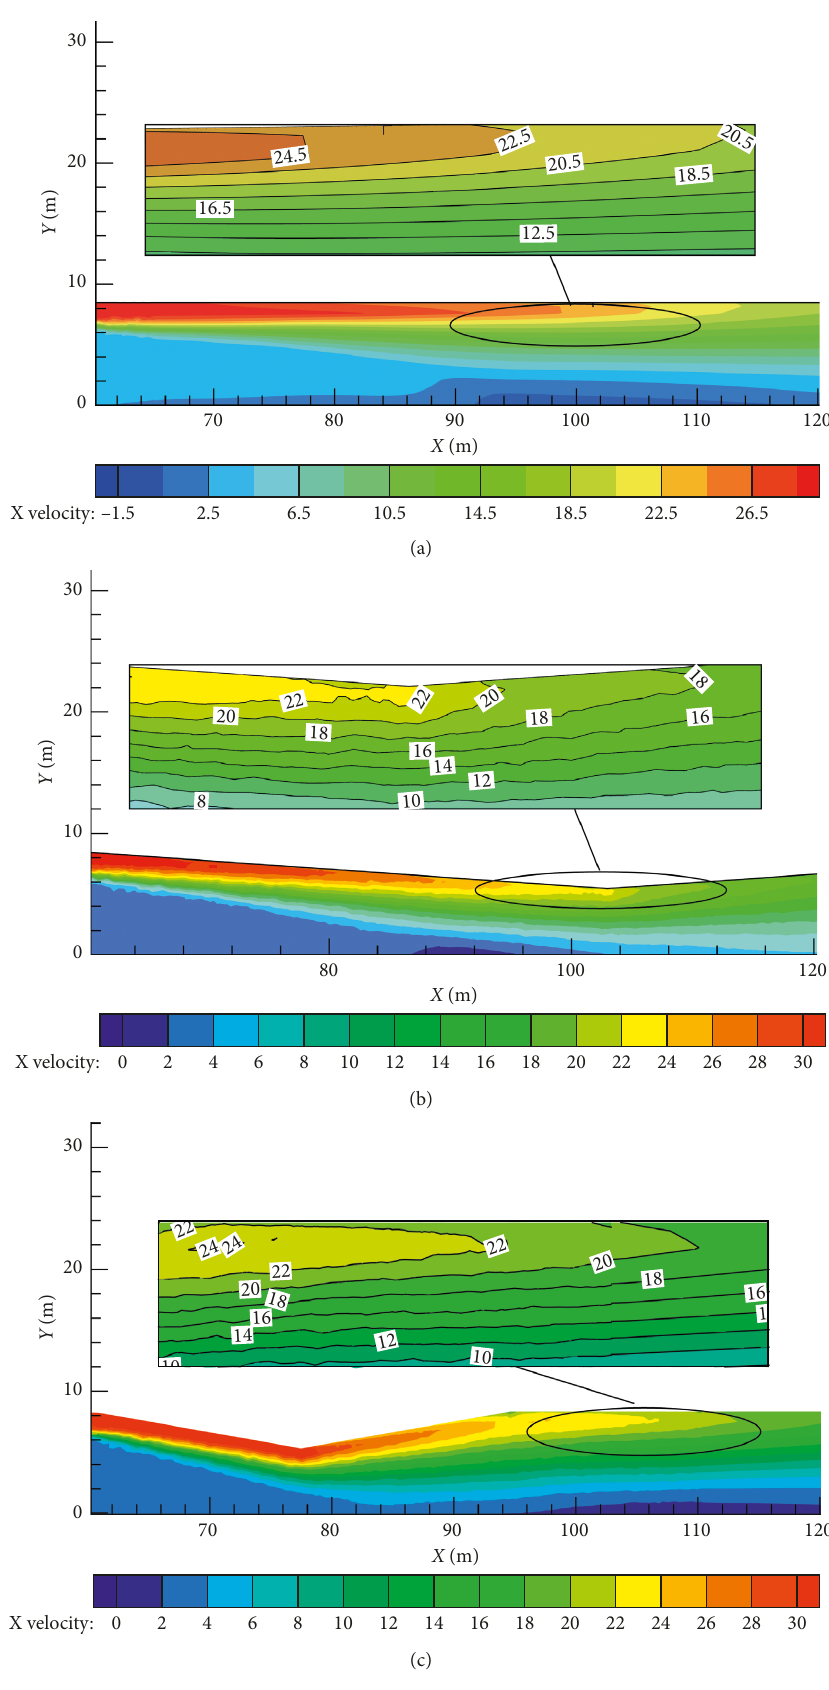
Figure 12: Local velocity distribution on X - Y plane for u